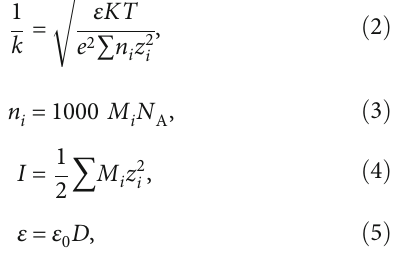
Figure 7: T 2 at peak as a function of ionic